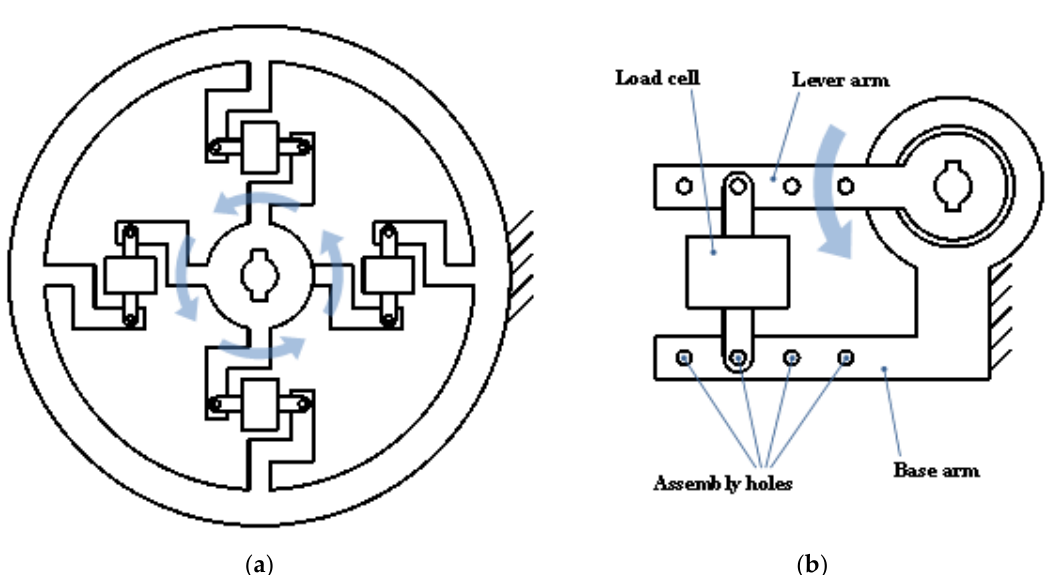
Figure 1. Schematics of the proposed torque sensors using load cells: ( a ) a circular torque sensor using four load cells and ( b ) a range-adjustable torque sensor using a load cell.